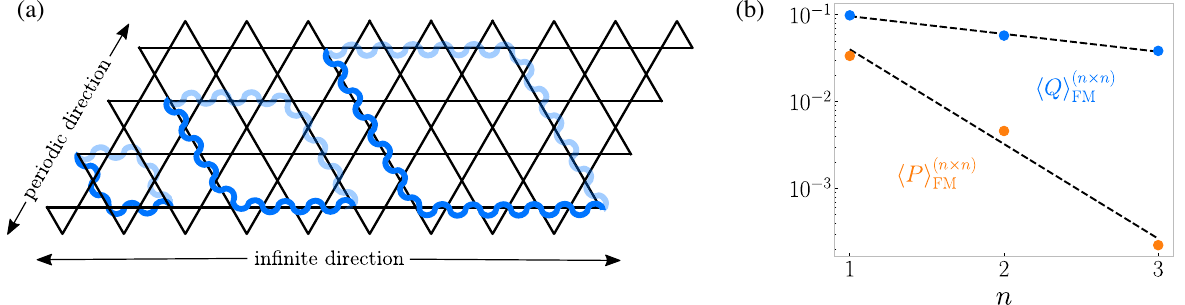
FIG. 19. The FM string order parameter in the V ð r Þ ∼ 1 =r 6 model. Similar to Fig. 18, except (a) we work on the YC-8 cylinder and (b) the DMRG results for the FM order parameters are now for the ruby lattice model discussed in Sec. III A, in particular, the blockade radius is R b ¼ 3 . 8 a , the detuning δ = Ω ¼ 5 . 5 , and we faithfully represent V ð r Þ ¼ Ω ð R b =r Þ 6 within a distance r ≤ 9 a